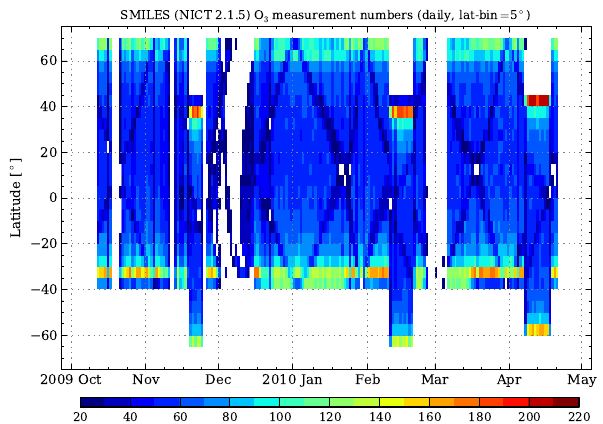
Fig. 1. Number of O 3 observations (scans) of the SMILES (NICT) v215 product. The data are accumulated in daily, 5 ◦ wide latitudinal bins. Measurements from both Band A and B are merged.